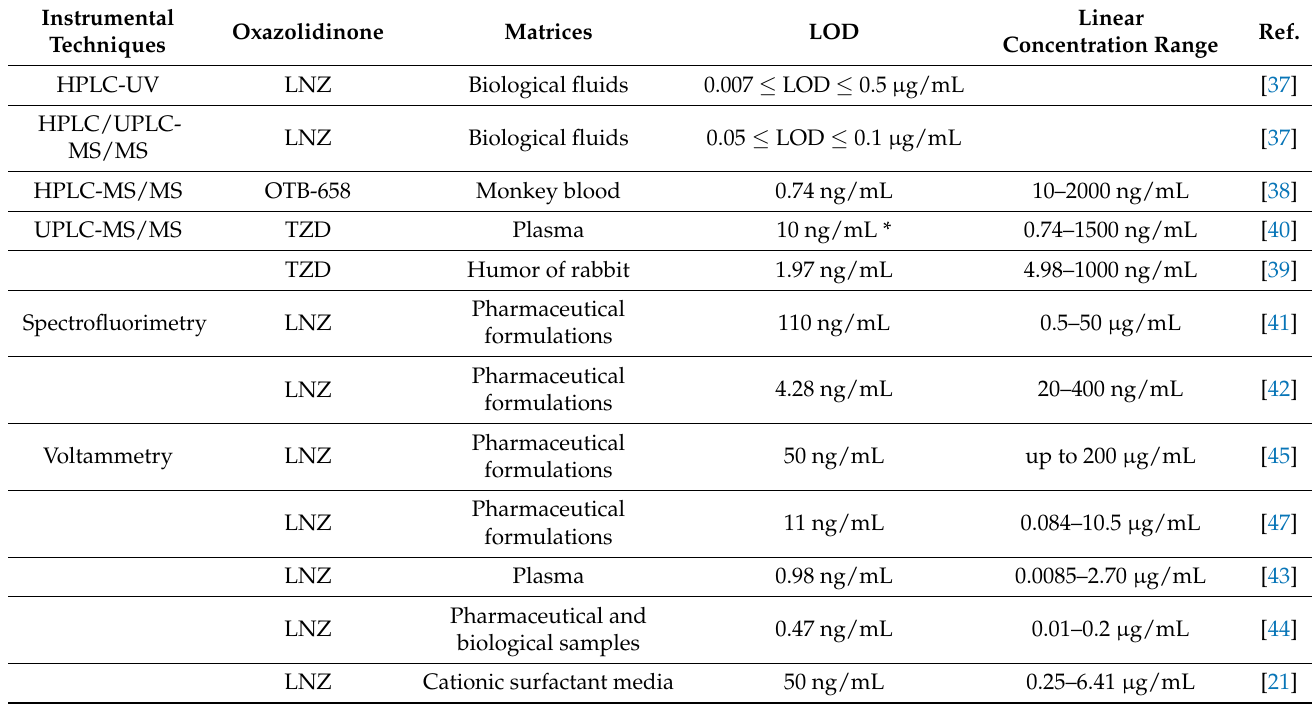
Table 2. Performance of different instrumental techniques for oxazolidinone